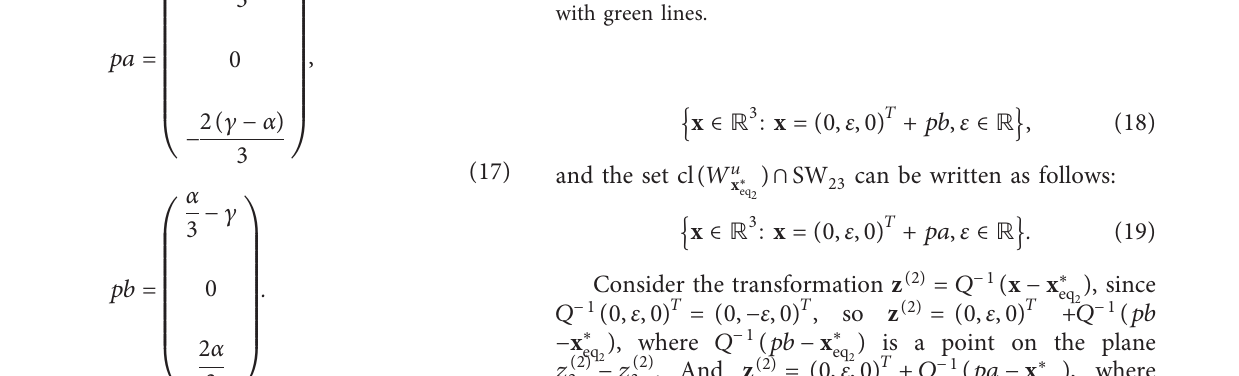
Figure 2: Projection of the stable and unstable manifolds and − x switching planes onto the x plane. The diagram shows the 1 3 location of the unstable manifold marked with red lines, the stable manifold marked with blue lines, and switching planes marked with green